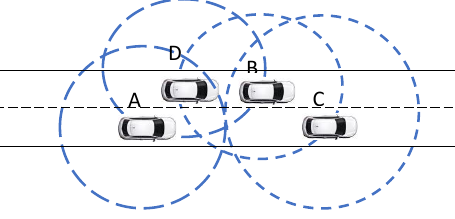
Figure 12. Conceptual illustration of the topological vehicle sequence shown in Figure 11.